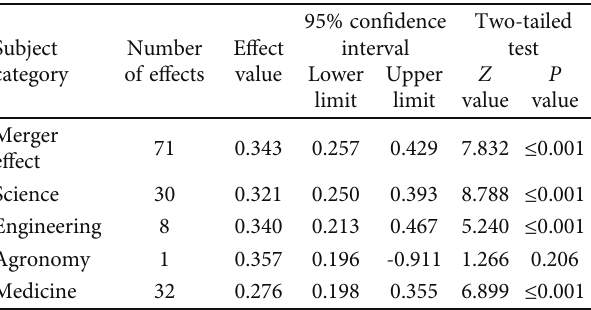
Table 5: Impact of di ff erent